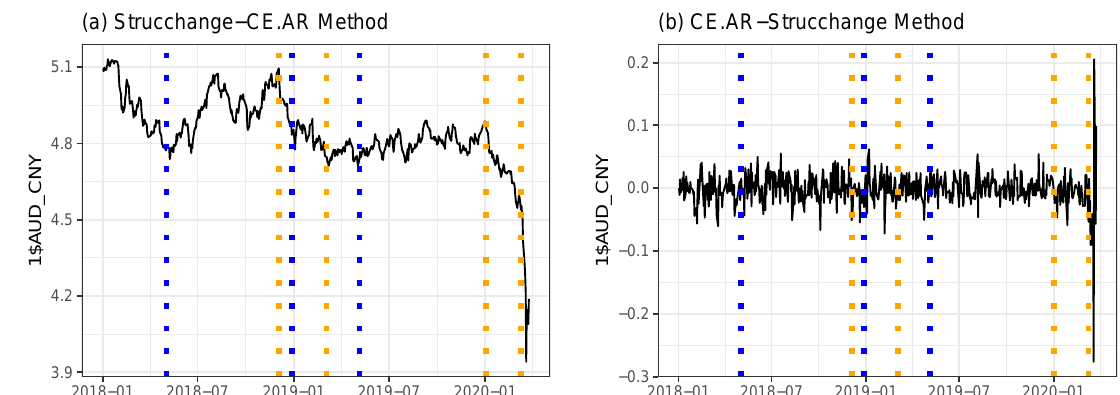
Figure 7. The orange dotted line in the plot represents estimated change-points using CE.AR, while the blue line represents the change-points detected by the strucchange method. In ( a ), we show the comparison of two methods on the daily exchange rate of AUD/CNY. ( b ) The change-point detection resulted by applying both methods on the first difference of AUD/CNY daily exchange rate. The data were downloaded from